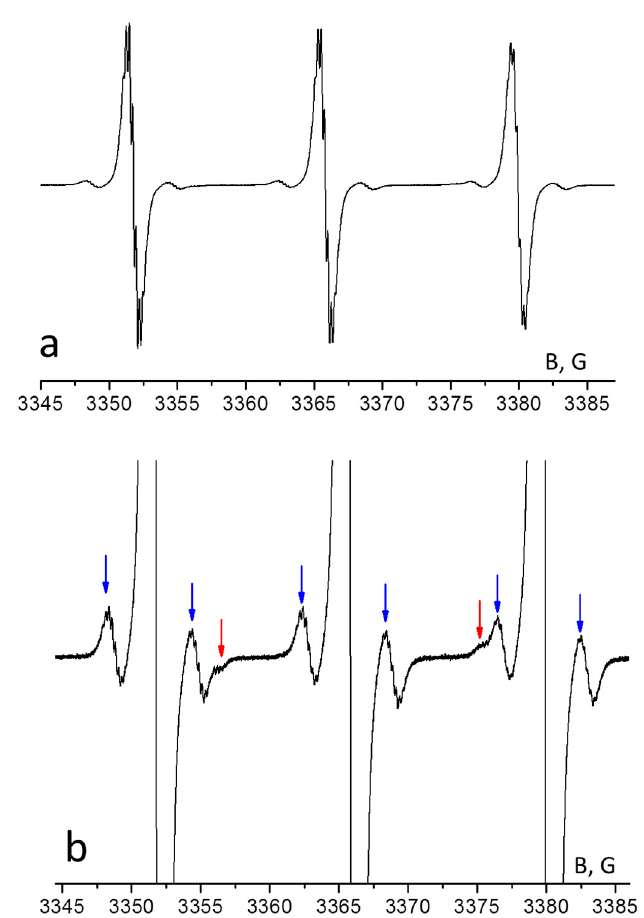
Figure 2. EPR spectrum of H1 in toluene at 298 K: ( a )—full spectrum, ( b )—satellite lines. The hyperfine lines of 13 C and 15 N are marked by blue and red arrows, correspondingly.